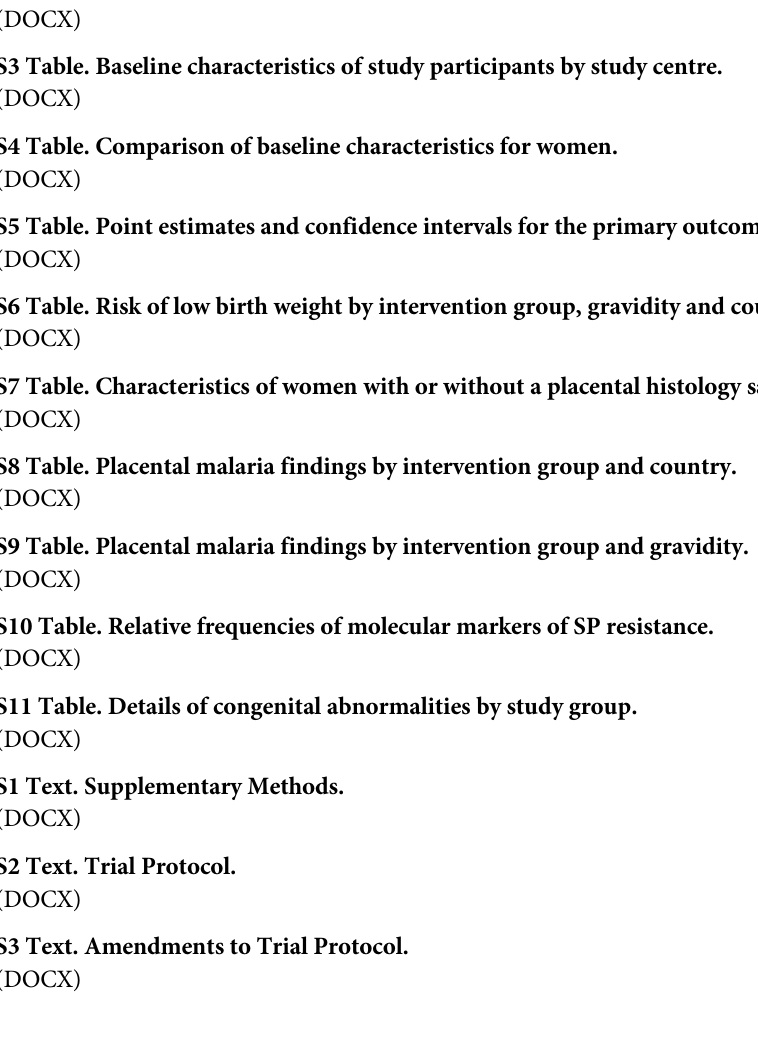
S3 Fig. Consort charts by centre — The Gambia. (DOCX) S4 Fig. Consort charts by centre — Ghana. S5 Fig. Consort charts by centre — Mali. S6 Fig. Distribution curves for birth weight by centre. (DOCX) S7 Fig. Non-inferiority plots for Ghana and the other 3 sites combined. (DOCX) S8 Fig. Distribution of haemoglobin concentration at fourth ANC visit by centre. (DOCX) S1 Table. Characteristics of the study